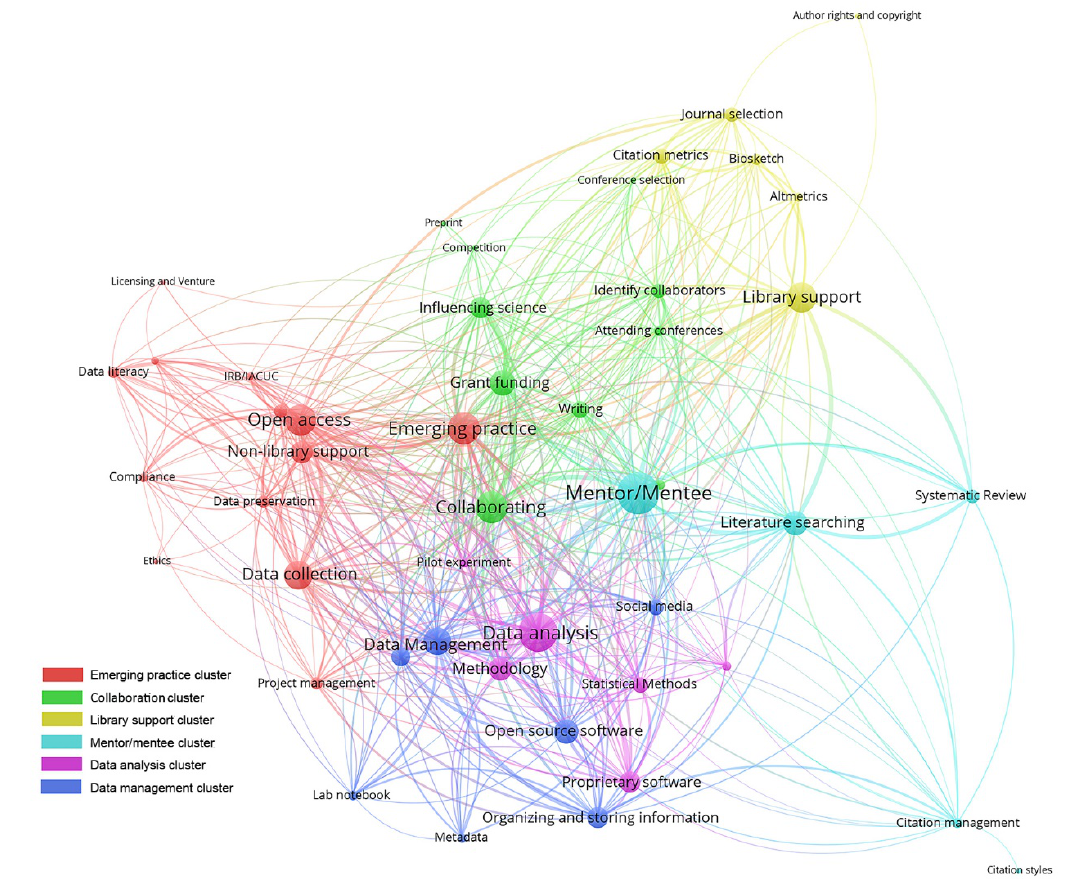
Figure 1 Co-occurrence of codes within the research